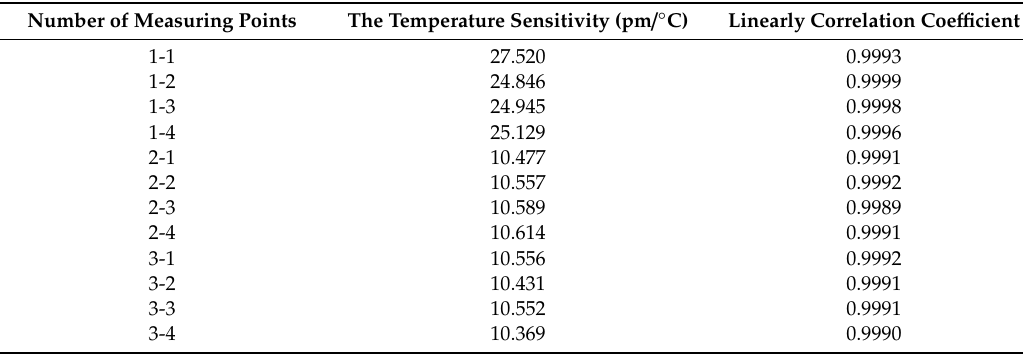
Figure 8. Calibration experiment system of the FBG temperature sensors. Table 1. Calibration results of measurement points of each FBG temperature